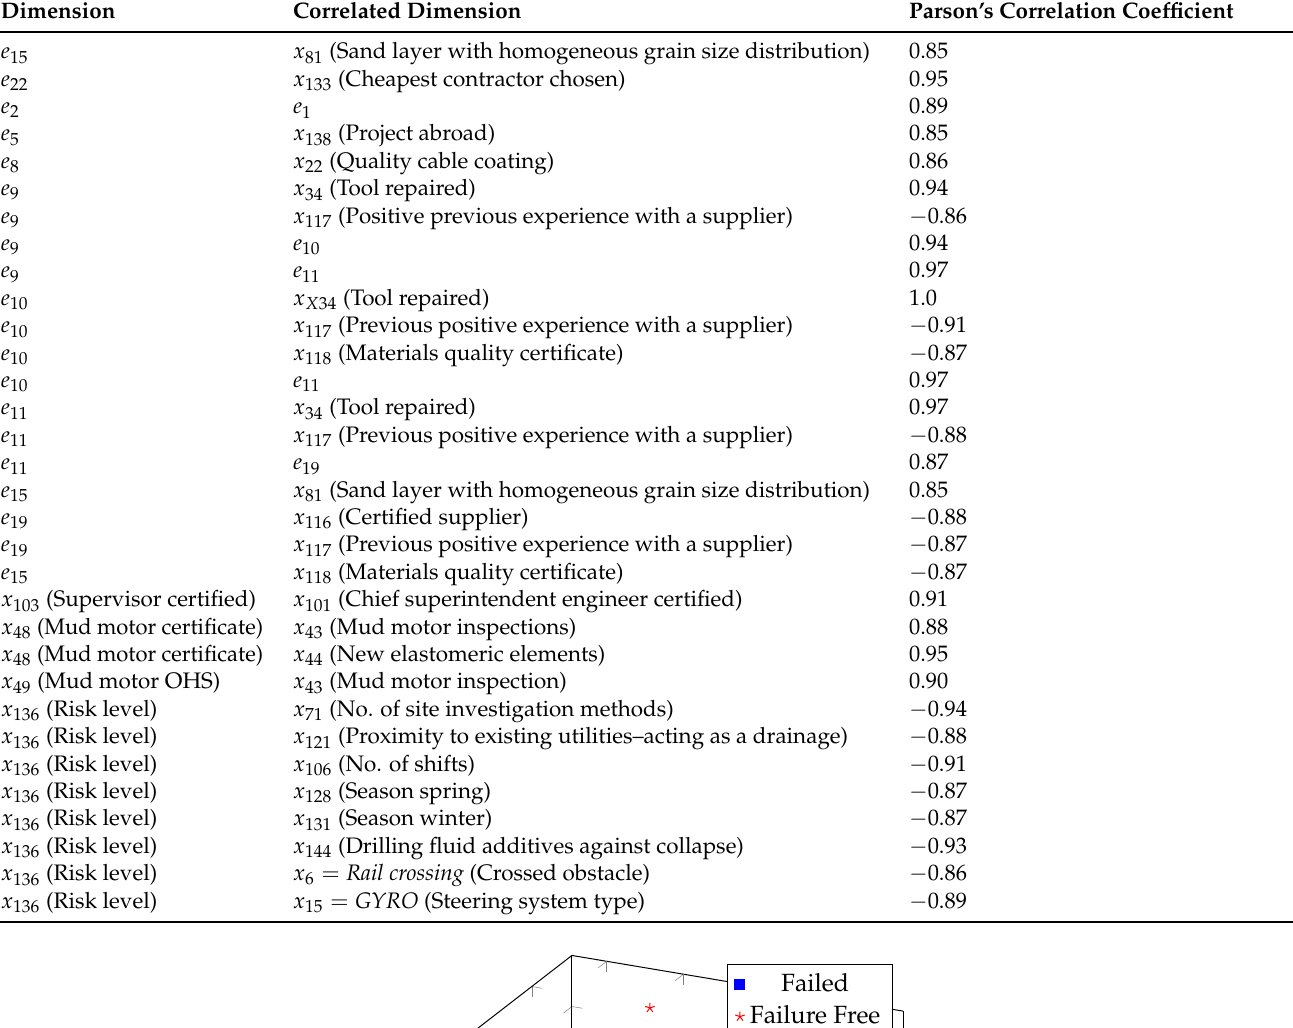
Table 5. Chosen correlated dimensions and their Parson’s correlation coefficients.